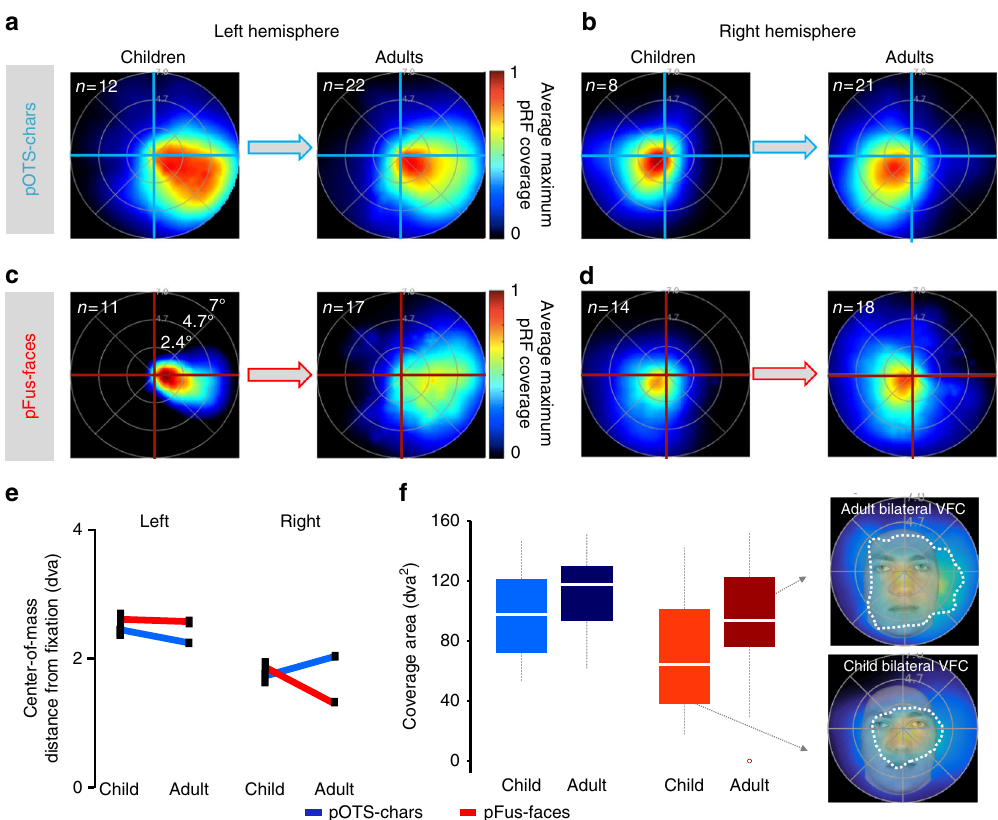
Fig. 4 Hemispheric asymmetry in coverage emerges in face and word regions. a – d For each region, visual fi eld coverage (VFC) was calculated using the average maximum pRF density coverage for each participant and then averaged across participants. The number of participants used to produce the VFC is indicated in the upper left of each panel. Innermost to outermost rings correspond to 2.4, 4.7, and 7 degrees of visual angle (dva), respectively. Arrows illustrates development from childhood to adulthood. a VFC of left pOTS-face. b VFC of right pOTS-chars. c VFC of left pFus-faces. d VFC of right pFus- faces. e Center-of-mass (CoM) distance of the VFC from fi xation illustrated for left and right pOTS-chars and pFus-faces across children and adults. A CoM distance of 2 indicates that the VFC is 2 degrees of visual angle from fi xation. Error bars: jackknife standard errors. f Left: VFC of bilateral pFus-faces and pOTS-chars in children and adults; white: indicating the median; box: 25th and 75th percentiles; whiskers: range. Right: overlay of the VFC of bilateral pFus-faces in adults (top) and children (bottom) on a face about 1 m from the observer (corresponding to ~6.5 dva). Dashed white contour: 50% density contour of the VFC. This contour covers more of the average-sized face in typical viewing distance in adults than